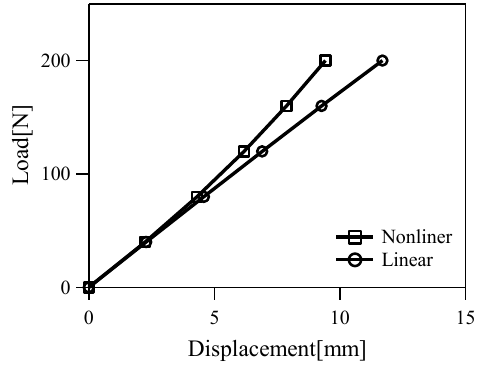
Figure 12. Relationships between load and displacement in the center of the racquet.